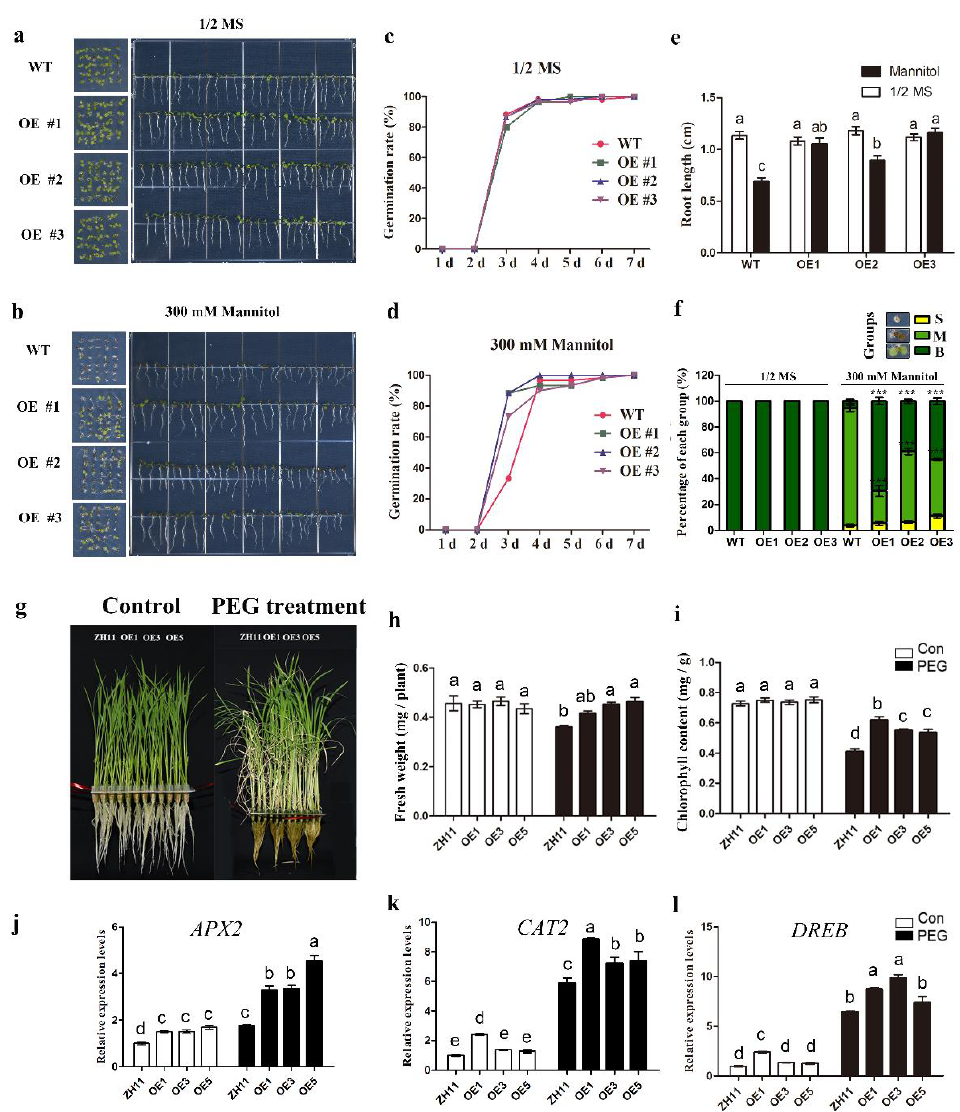
Figure 7. Over-expression of the OsHsB4b gene in Arabidopsis and rice enhances plants resistance to drought stress. Photographs of 7-day-old WT and OsHsB4b -over-expressed Arabidopsis seedlings grown on 1/2 MS ( a ) and 1/2 MS containing 300 mM Mannitol ( b ); The germination rates ( c , d ) and root lengths ( e ) of seedlings in ( a , b ); ( f ) Percentage of B (big), M (moderate), and S (small) seedlings in ( a , b ). According to the one-way ANOVA and post-hoc Tukey’s test, the significant differences were indicated by different letters in ( e ), n ≥ 40. Statistical comparisons were performed by two-tailed independent sample t -test ( *** p < 0.001) in ( f ); ( g ) Photographs of WT and OE rice plants exposed to 20% PEG treatment. Fourteen-day-old rice seedlings were treated with 20% PEG 6000 for 8 days followed by recovering for 7 days. Thirty plants per line were used per replicate; ( h , i ) The fresh weight ( h ) and the chlorophyll content ( i ) of rice seedlings in ( g ); ( j – l ) The expression levels of APX2 , CAT2 , and DREB in leaves of WT or OE rice lines upon PEG treatment. Different letters indicate significant differences at p < 0.05 according to one-way ANOVA and post-hoc Tukey’s test.